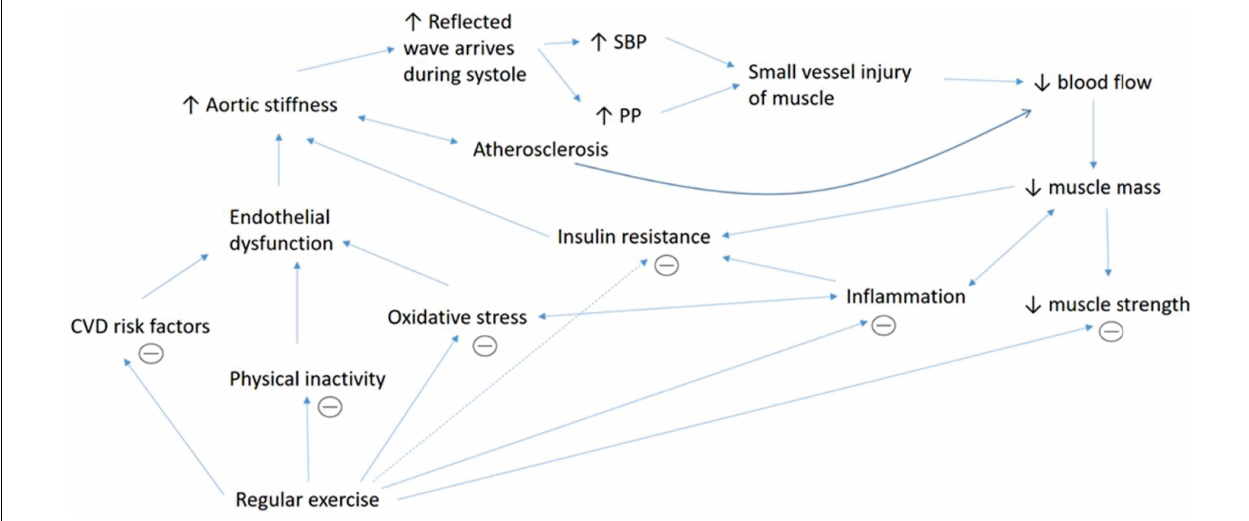
FIGURE 2 | Summary of the underlying mechanisms that explain the association between AS and muscle indices. The association between aortic stiffness and muscular indices is complex, involves multiple intermediators and may act in a vicious cycle. Increased aortic stiffness leads to increased wave reflection and augmentation of systolic blood pressure (SBP) and pulse pressure (PP), which causes injury to small vessels in the organ such as muscle. Aortic stiffness which is also associated with atherosclerosis causes reduced blood supply to the muscle that impairs nutrient supplementation. This contributes to muscle death and reduced muscle mass. Reduced muscle mass also contributes to lower muscle strength. Besides, lower muscle mass causes less glucose intake into the muscle cells, which leads to insulin resistance. Poor muscle removal after cell death leads to fat infiltration and inflammation. Increased inflammation itself may cause proteolysis, reduced muscle mass, insulin resistance and increased oxidative stress. Oxidative stress causes proteolysis by causing myocardial DNA damage and stimulating the release of various inflammatory mediators. Inflammation, oxidative stress, various cardiovascular diseases (CVD) risk factors and physical inactivity are linked to endothelial dysfunction, which leads to increased aortic stiffness. Regular physical activity increases muscle mass and strength and improves endothelial function, oxidative stress, CVD risk factors, insulin resistance and inflammation which subsequently reduces aortic